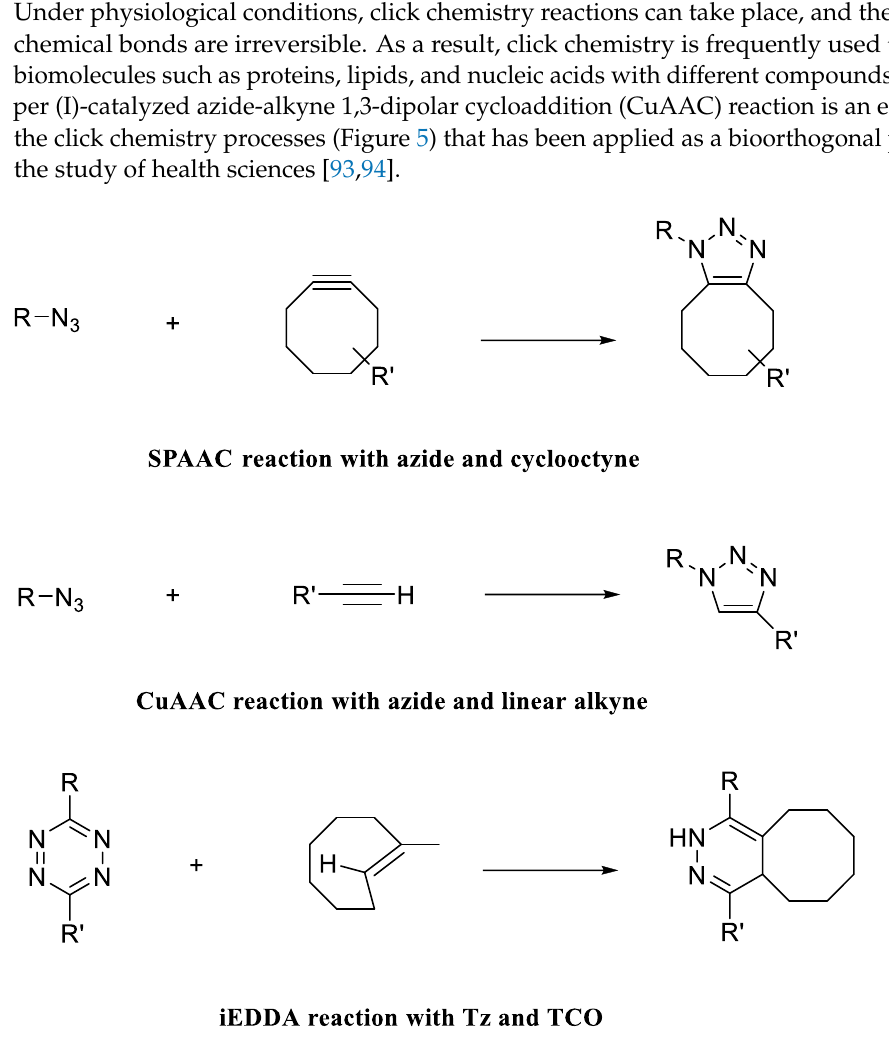
Figure 5. Schematics of various click chemistry reactions used to modify exosomes. By presenting an azido moiety on the surface of the exosome through metabolic gly- coworkers introduced a simple and efficient exosome labeling strategy. To better under-